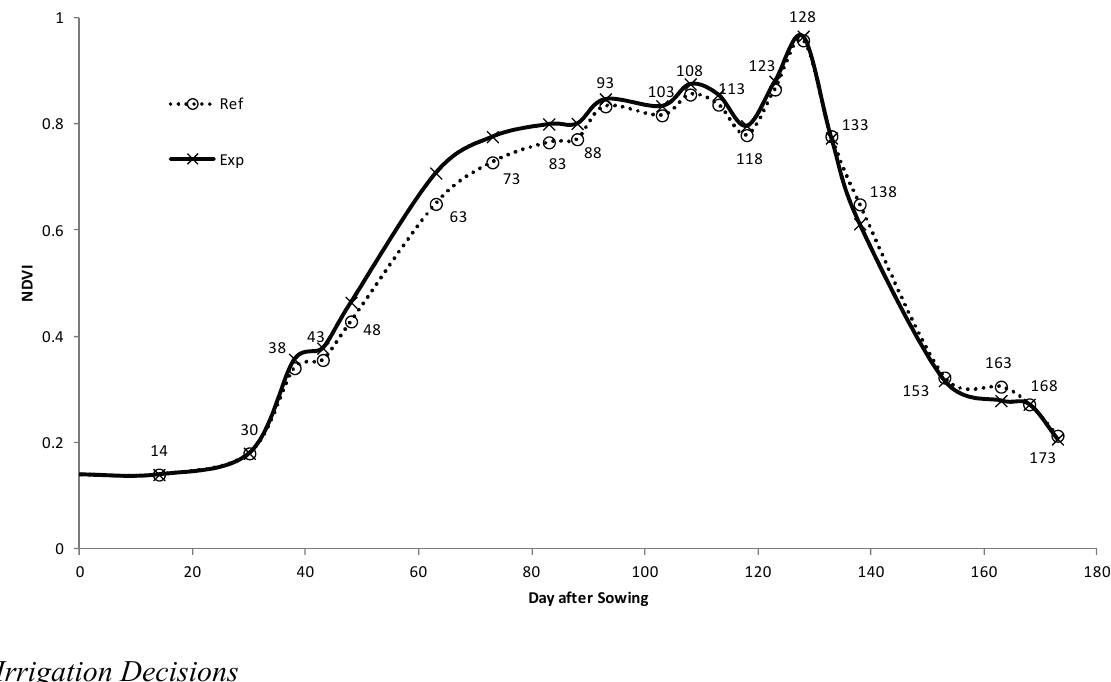
Figure 5. Evolution of NDVI for the two plots: Reference (Ref) and Experimental (Exp). Note that the first three points come from SPOT5 and others from SPOT4. The DaS of each input image has been